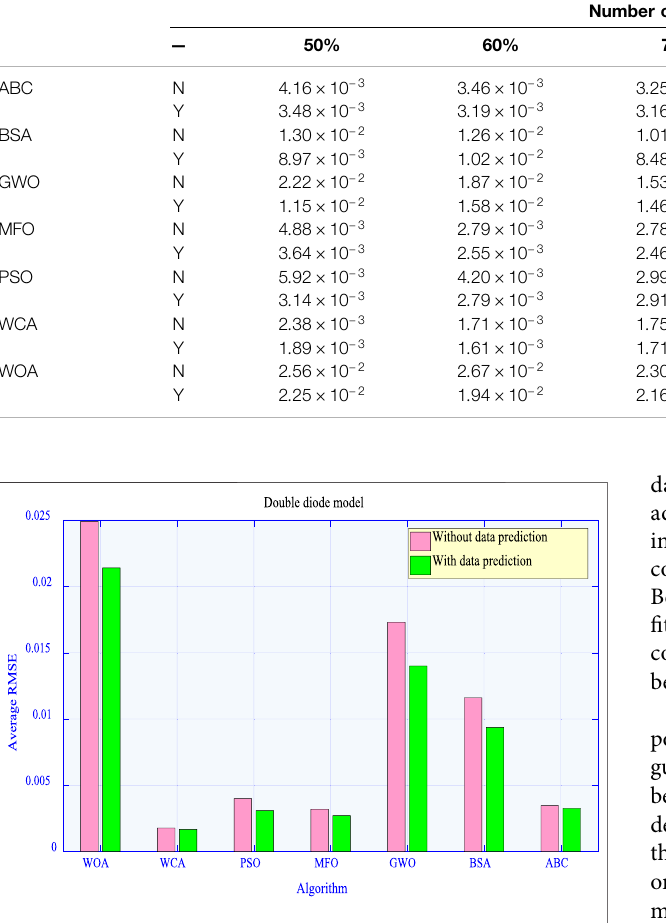
TABLE 4 | Average RMSE obtained by various algorithms for the DDM with six measured data. Algorithm Average RMSE